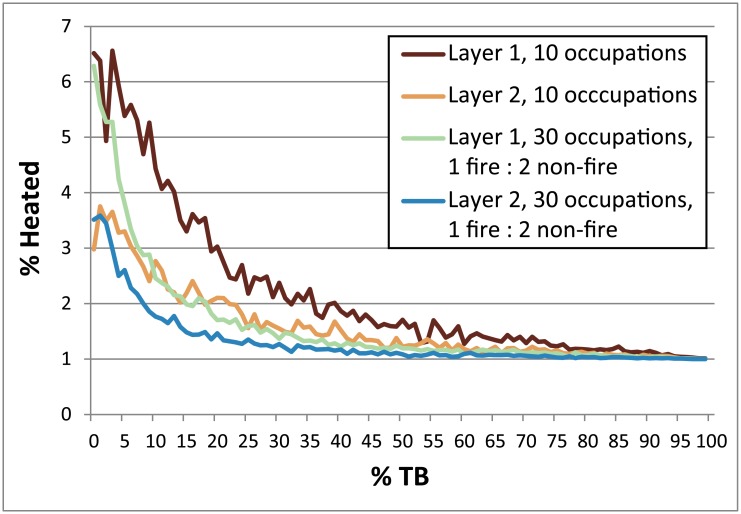
Chart comparing a layer with hearths every third occupation (30 occupations total) with a layer with 10 occupations and fire in every occupation.Parameters: Fires Random/Lithic Scatters Random (FR/LSR), 1 fire, fire size 1, 4 lithic scatters, 0–100% TB, 1% introduced lithics.